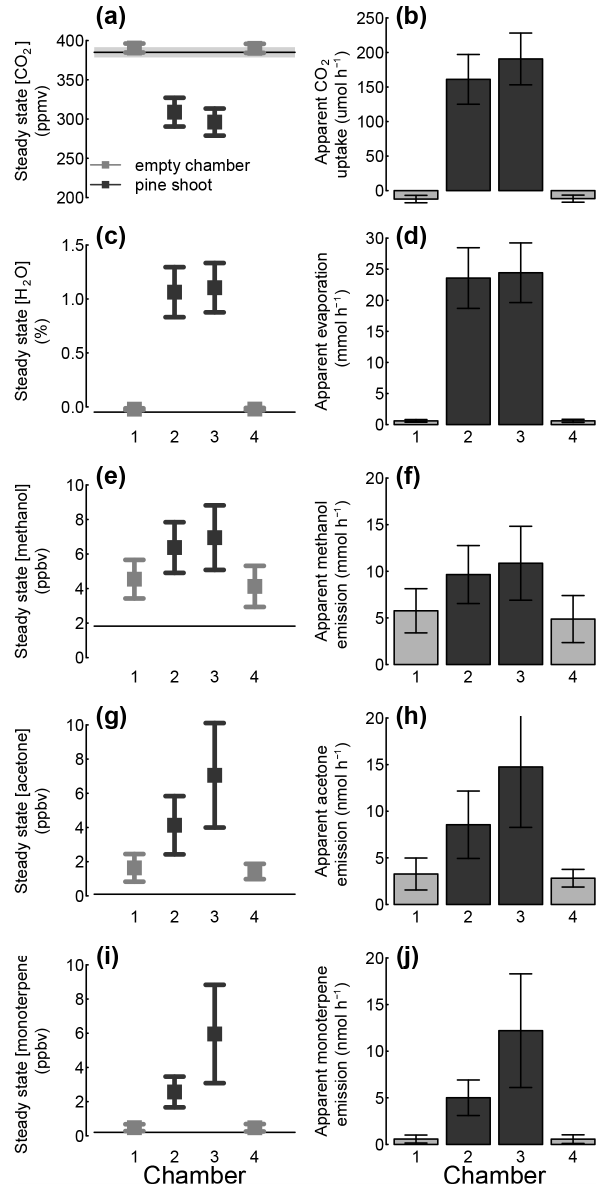
Figure 8. Observed steady-state mixing ratio of CO 2 (a) , water (c) , and VOCs (e, g, i) in outgoing air ( C out ) during dynamic cham- ber measurements of two empty chambers (grey) and two chambers with pine shoots (black). The mixing ratios of CO 2 water in in- going air ( C in ) are indicated by the horizontal lines in each plot. Further, apparent CO 2 uptake (b) , transpiration (d) , and VOC emis- sion (f, h, j) rates calculated from these mixing ratios. Error bars and the shaded area around the horizontal lines indicate 1 standard